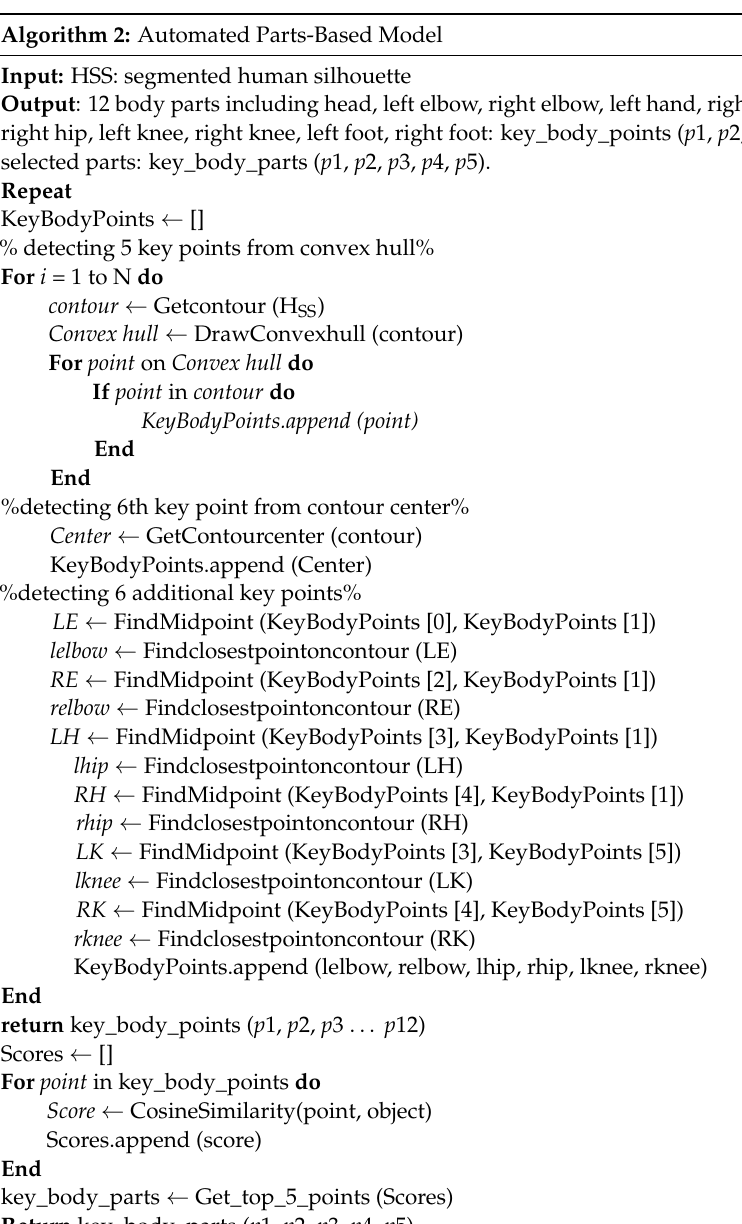
Algorithm 2: Automated Parts-Based